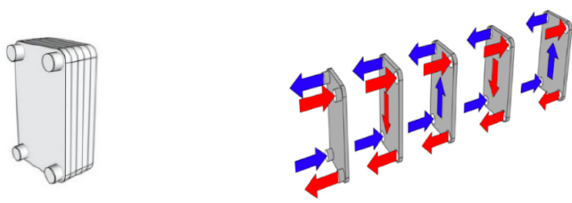
Figure 3. The schematic of the flat plate heat exchanger.